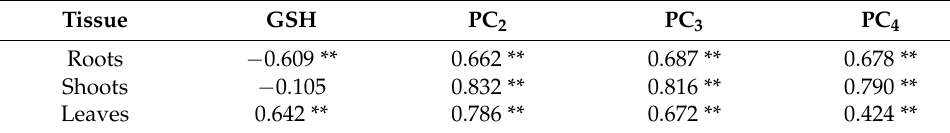
Table 2. The responses of different thiols to Cd concentrations in different tissues. Tissue